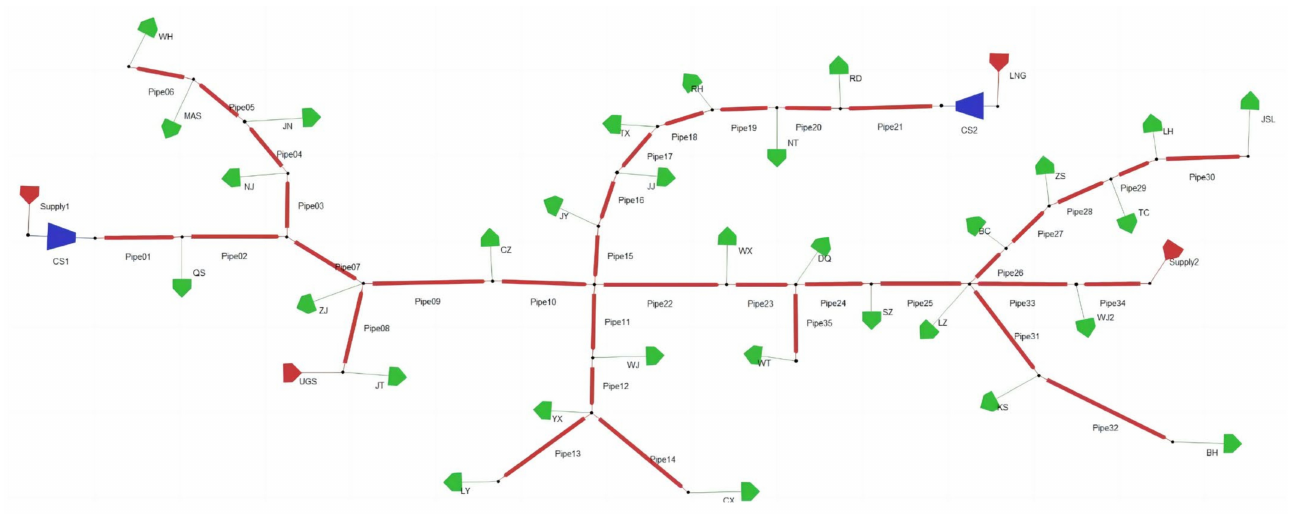
Figure 7. Topological structure of natural gas pipeline